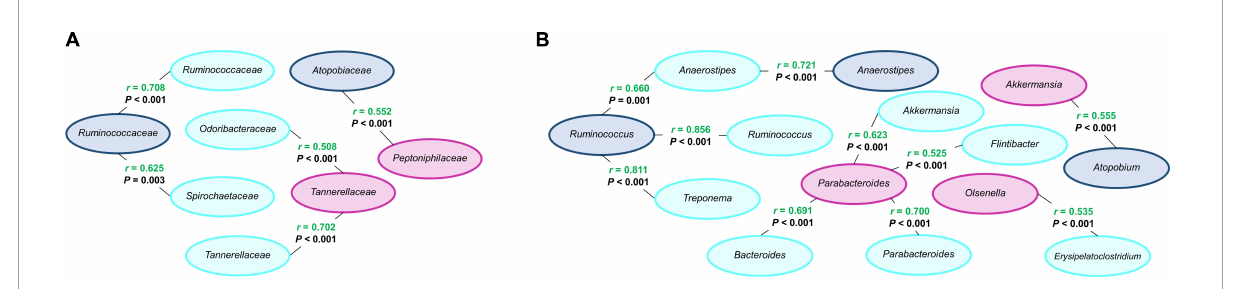
FIGURE6 Correlations between modified microbial families (A) and genera (B) from feces of lactating sows (navy blue, n = 21), milk (light blue, n = 21), and feces of suckling piglets (purple, n = 84). Pearson correlation coefficient ( r ) in green indicates a positive correlation. A significant correlation level was set at r > 0.5 and P <